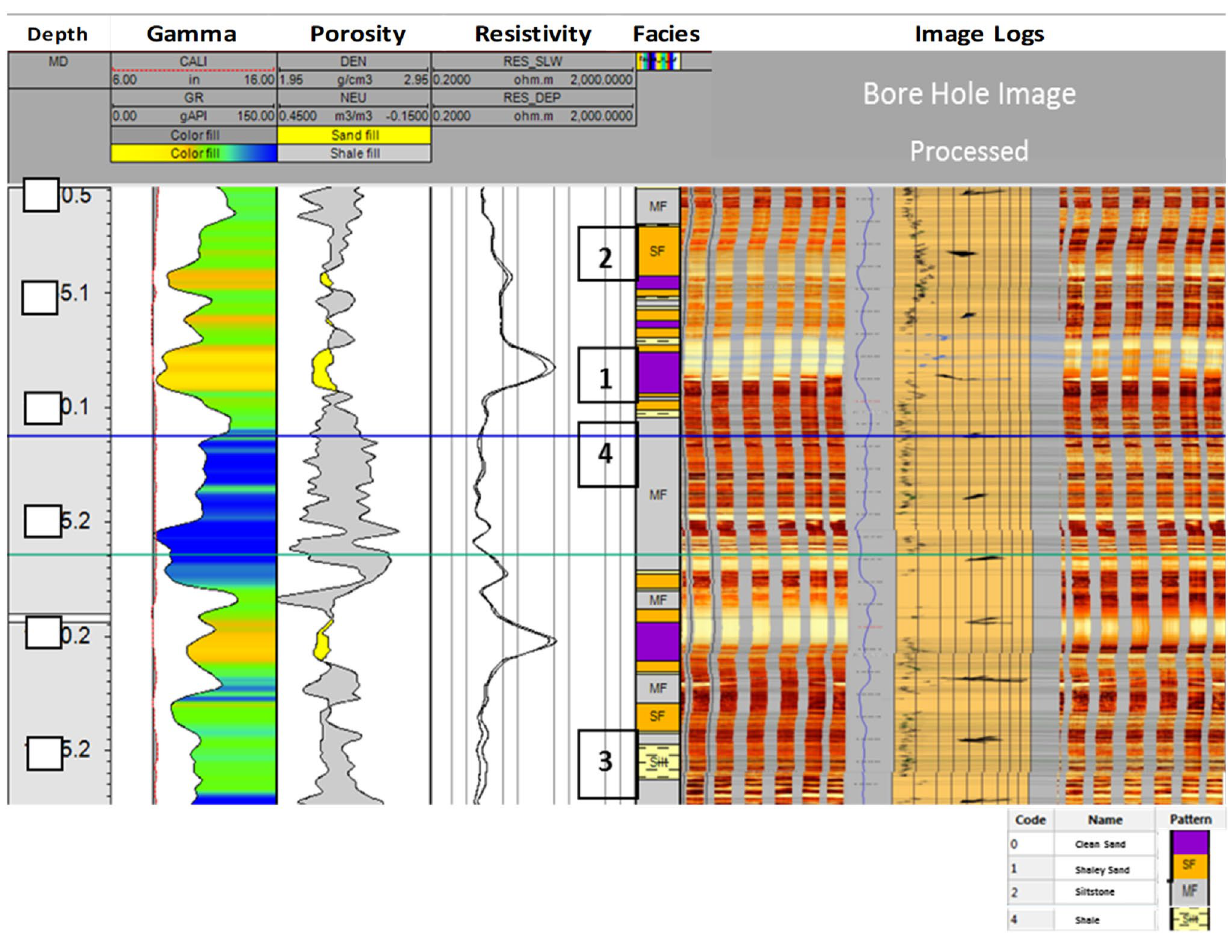
Fig. 9 Well-1 bore hole logs gamma ray, density, neutron, resistivity and electrofacies discrete logs integrated with bore hole image